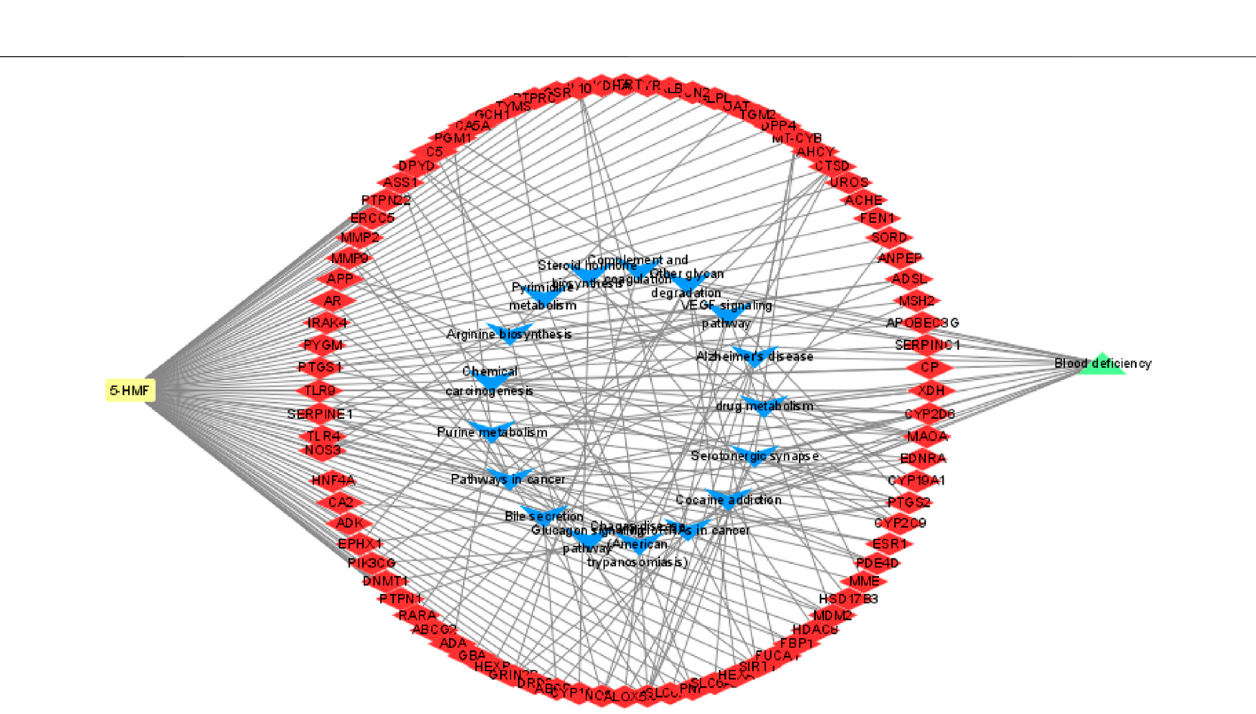
FIGURE3| Theblue trianglenode representsthecommon pathway of5-HMFand BDS, while the red quadrilateral node representsthecommon target of5-HMF and BDS.